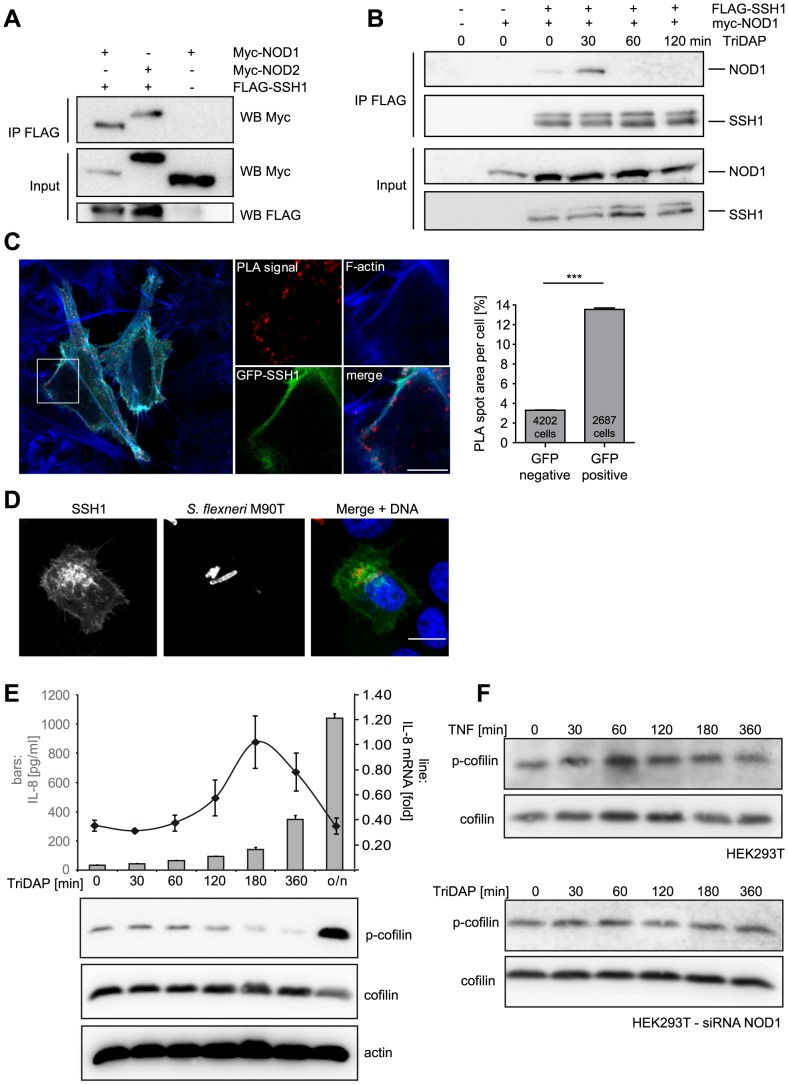
SSH1 interacts with NOD1 and regulates cofilin phosphorylation after NOD1 activation.(A) Co-immunoprecipitation of ectopically expressed SSH1 with NOD1 and NOD2 in human HEK293T cells. Flag-SSH1 was precipitated using a Flag-specific antibody in all samples. (B) Co-immunoprecipitation kinetic of NOD1 and SSH1 in HEK293T cells treated for the indicated time with 500 nM TriDAP. Flag-SSH1 was precipitated using a Flag-specific antibody. (C) In situ PLA detection of the interaction between GFP-SSH1 (shown in green) and Flag-NOD1 in transiently transfected HeLa cells. Protein–protein interactions are visualized as small, distinct red spots (PLA signals). F-Actin (blue) was stained with Alexa633-labeled phalloidin. Shown is a single z section. Scale bar 5 µm. Right panel: Quantification of the total spot area per cell. Significance was calculated by student's t-test (unpaired, two-tailed), p<0.0001. (D) Indirect immunofluorescence study of ectopically expressed myc-SSH1 in HeLa cells after 30 min of infection with S. flexneri (MOI = 10). Bacteria were stained with a LPS specific antibody and are shown in red in the merge image together with DNA staining in blue. Bar: 10 µm. (E) HEK293T cells expressing low amounts of NOD1 were stimulated with TriDAP. IL-8 release (bars) was measured by ELISA (accumulation in supernatant since t = 0) and IL-8 mRNA (line) by qPCR (upper panel). Values are mean + S.D. (n = 3). Cofilin phosphorylation (S3) was monitored by Western Blot analysis (lower panels). Probing for total cofilin and actin served as loading controls. One representative experiment out of three is shown. (F) p-cofilin and total cofilin protein levels were analyzed in HEK293T cells at the indicated time-points after stimulation with 50 ng/ml TNF (upper panel). Alternatively NOD1 was silenced by siRNA treatment for 48 h and cells were stimulated with TriDAP (lower panels) (see also Figure S6).